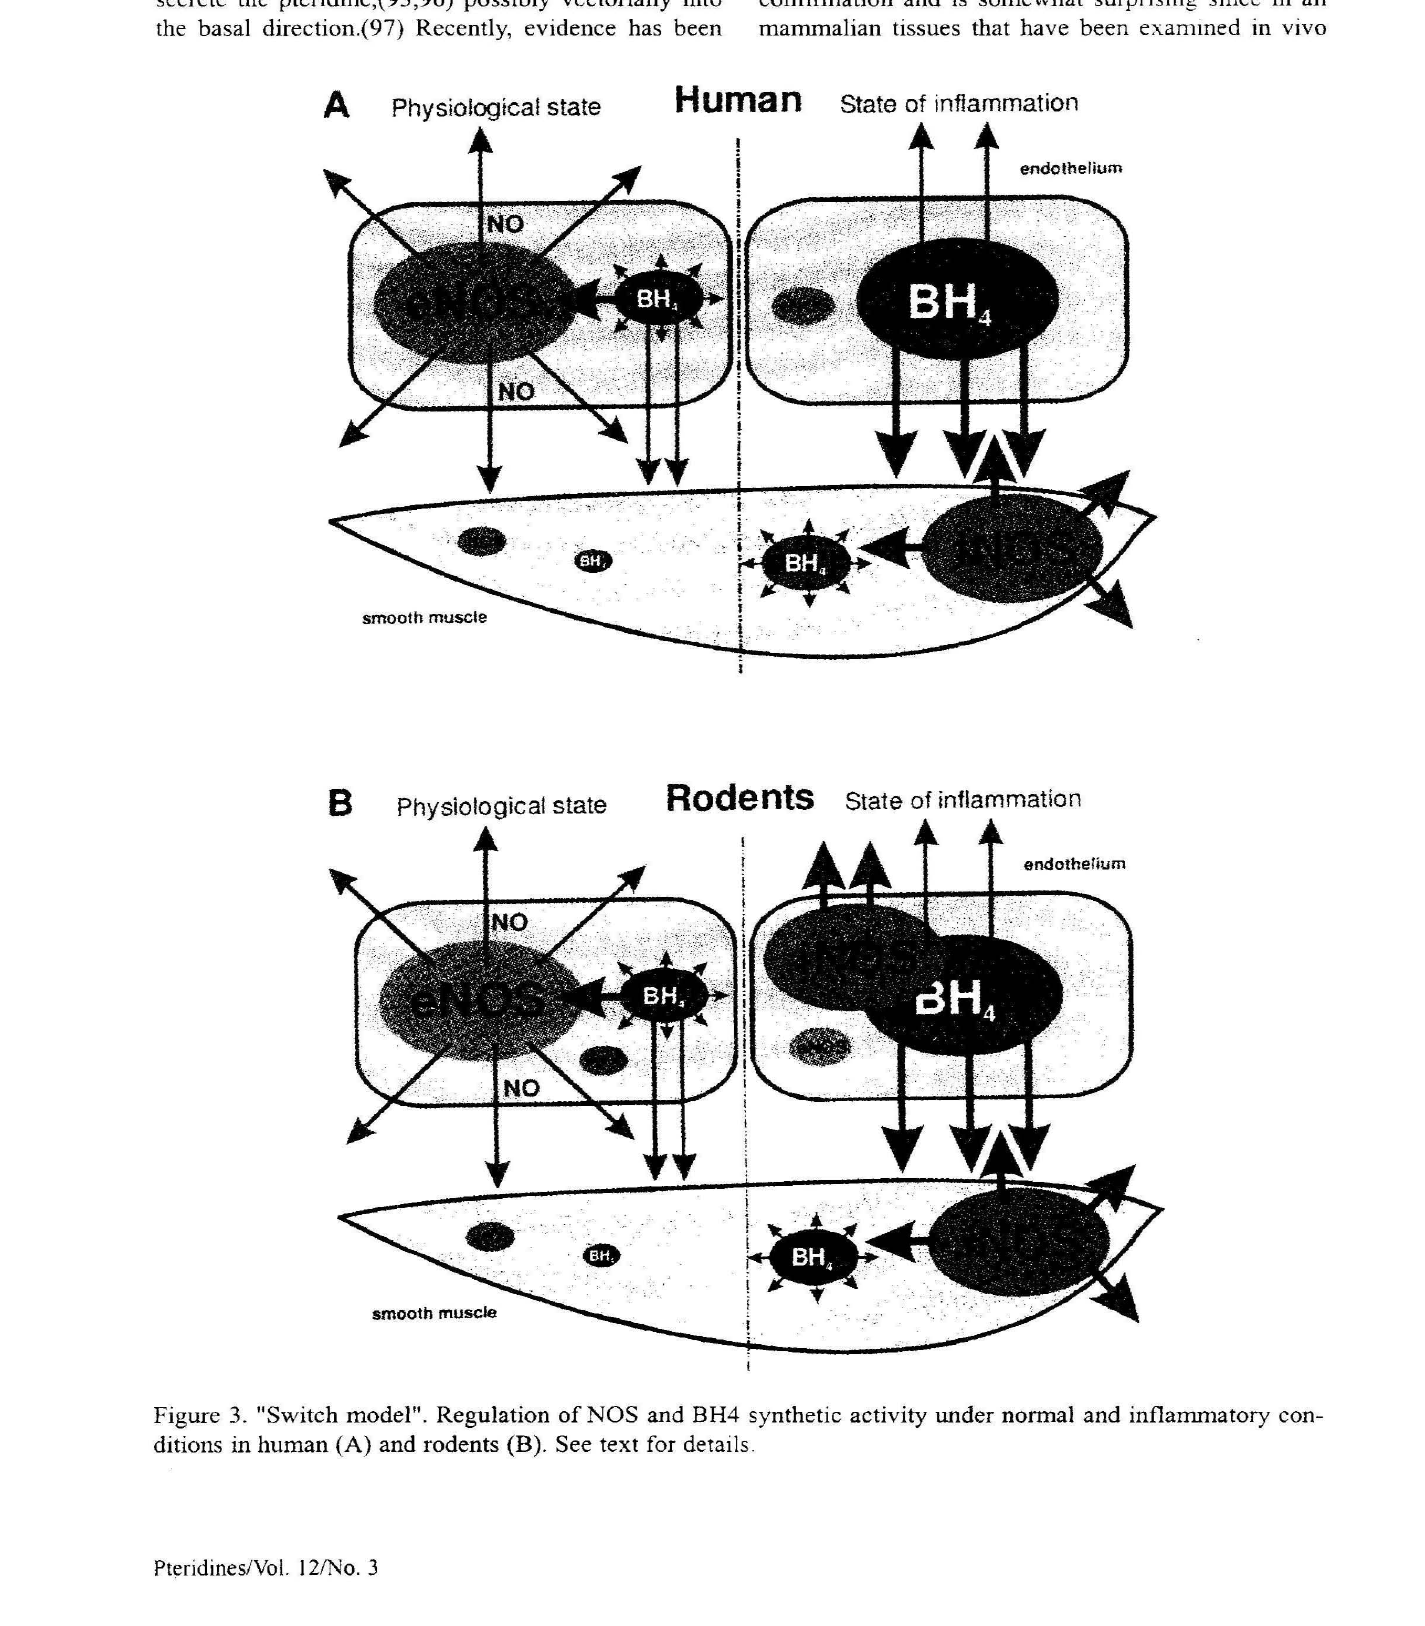
Figure 3. "Switch model". Regulation of NOS and BH4 synthetic activity under normal and inflammatory con ditions in human (A) and rodents (B). See text for details.